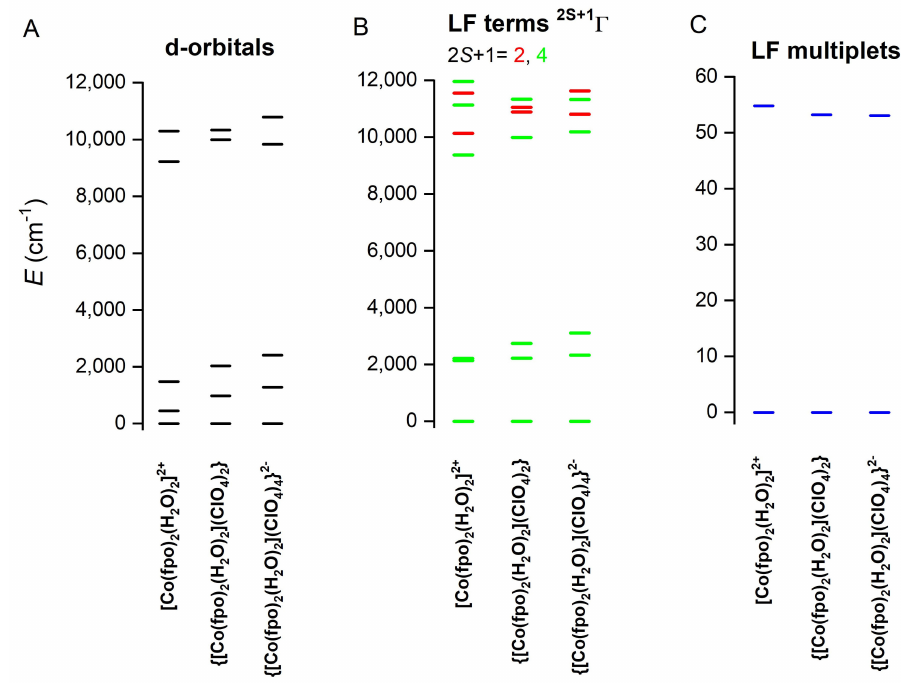
Figure 8. The graphical output of the CASSCF / NEVPT2 calculations with CAS(7,5) for the mononuclear molecular fragments of 2. The plot of the d-orbitals splitting calculated by ab initio ligand field theory (AILFT) ( A ), low-lying ligand-field terms ( B ), and ligand-field multiplets—Kramers doublets ( C ). The doublet and quartet spin states are shown in red and green,